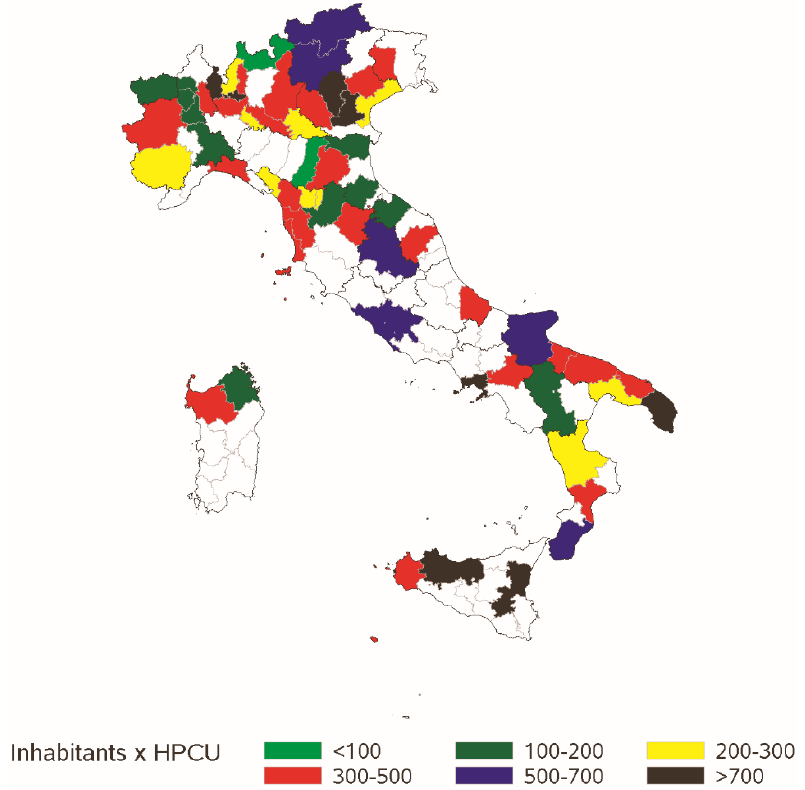
Figure 1. HPCSs enrolled in the study by Italian province (colored areas) and number of inhabitants (thousands) per HPCS in each province in 2013 (Regions-bold contours).